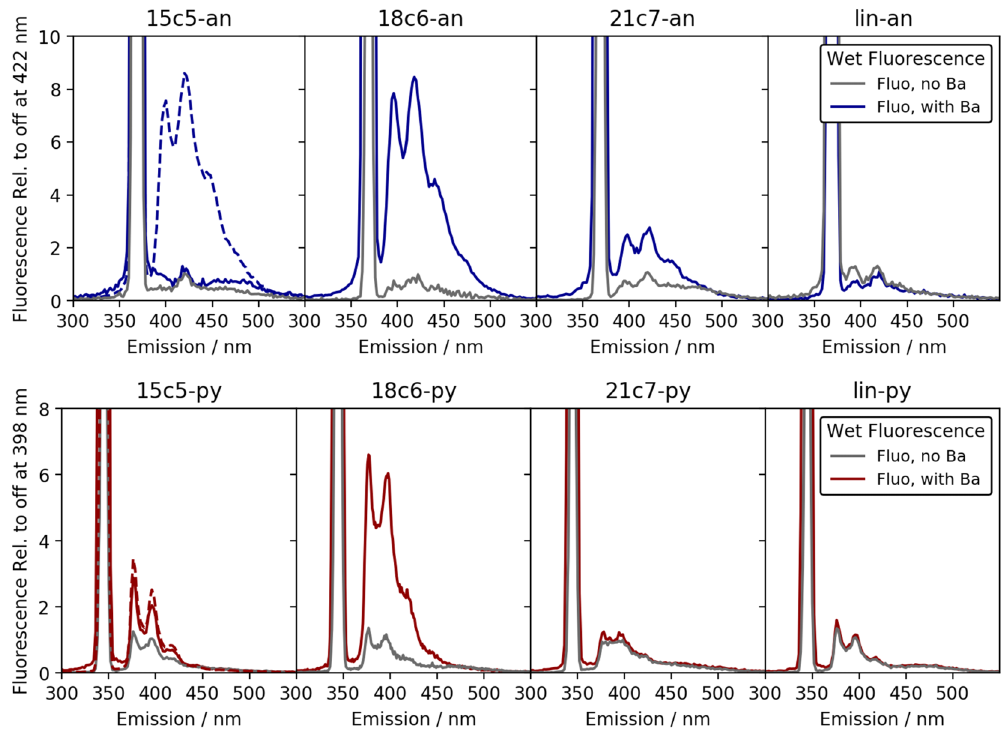
Figure 3. Fluorescence response of each species in solution at concentration of 2 µ M and barium at 37.5 mM. In each panel the grey line shows the emission contribution from scattering and fluorescence in the buffer alone. The coloured lines show the response with barium added. The dashed line shows a higher concentration study for comparison, with the 15c5 fluorophores at 90 µ